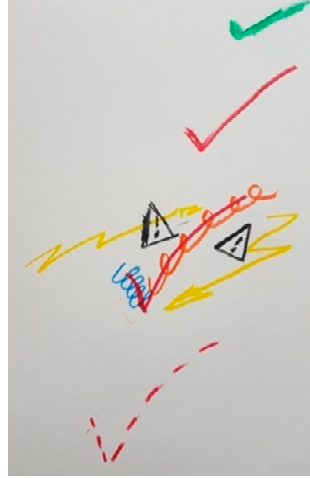
Figure 17. P1’s perception of DBS effects.